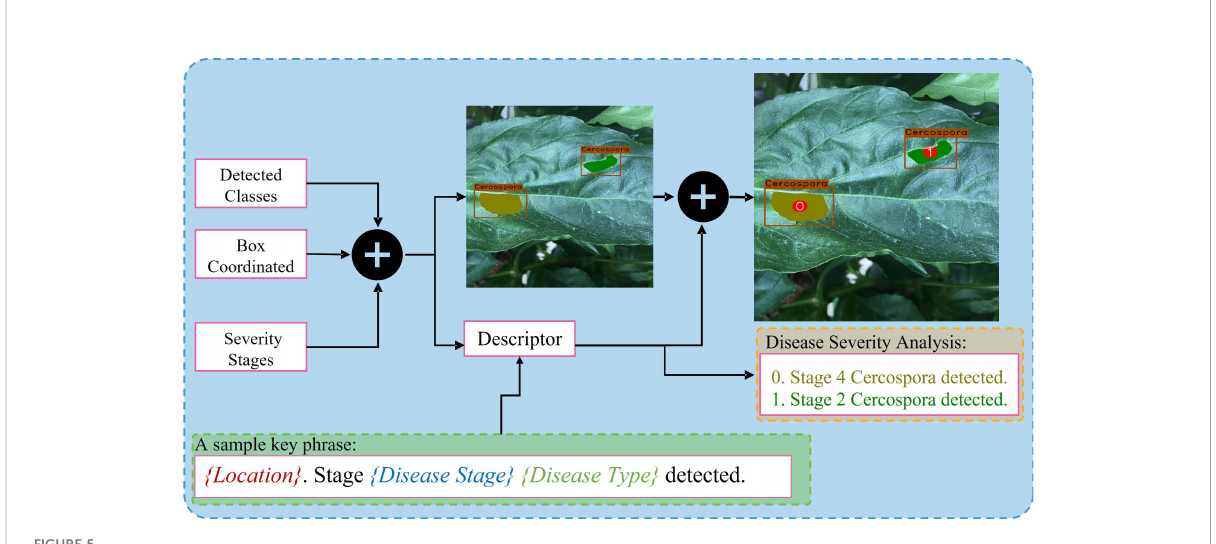
FIGURE 5 Overview of the process being performed by the integration